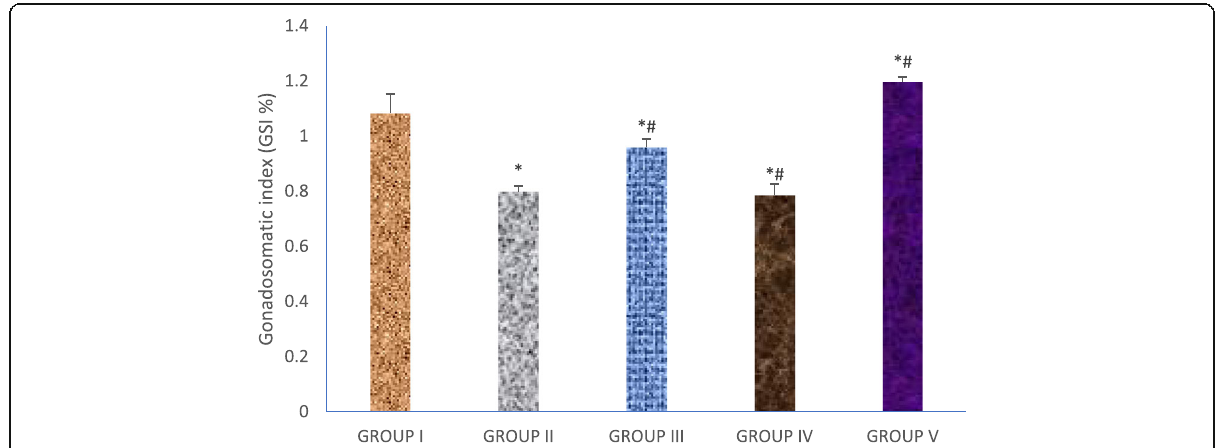
Fig. 1 Effect of MLVA on gonadosomatic index of rats treated with nitrobenzene. Data are given as mean ± SD of rats per group. n = 6. MLVA: methanolic leaf extract of Vernonia amygdalina , *: Values differ significantly from group I (control) ( P < 0.05). #: Values differ significantly from group II